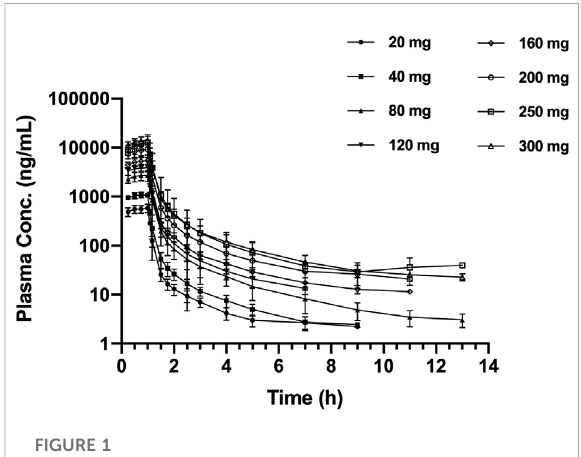
proportionality, and the results are shown in Table 4. The 90% CIs of the slope β of C max and AUC 0-t were not within the prede fi ned acceptance range, and the direction of the deviation was higher than expected from fi tting. The results suggested that the main pharmacokinetic parameter of SAA is the lack of proportionality with the dose range after single dosing.